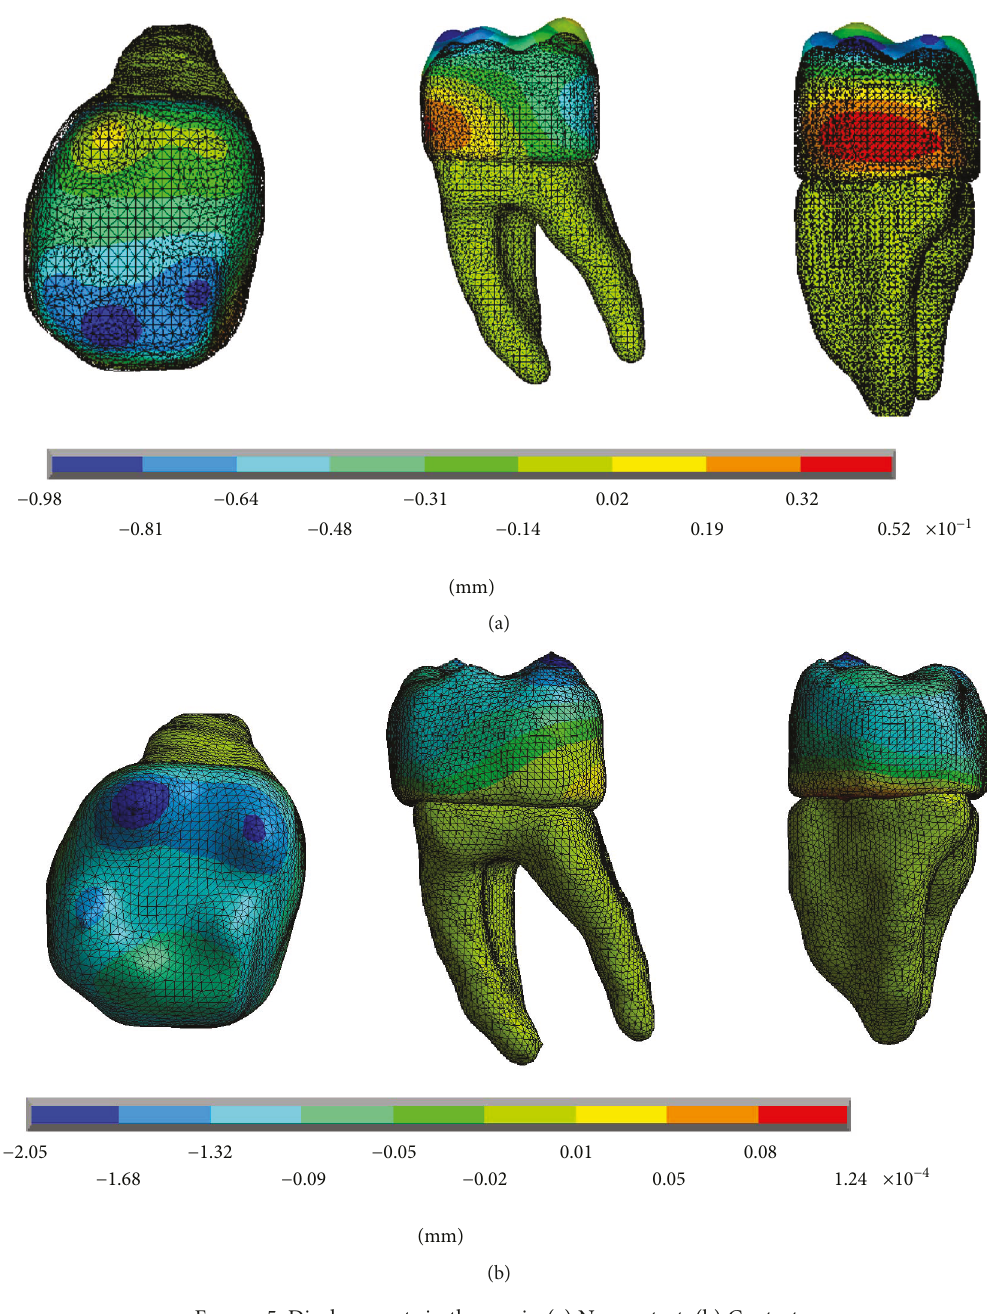
Figure 5: Displacements in the y -axis. (a) Noncontact. (b)